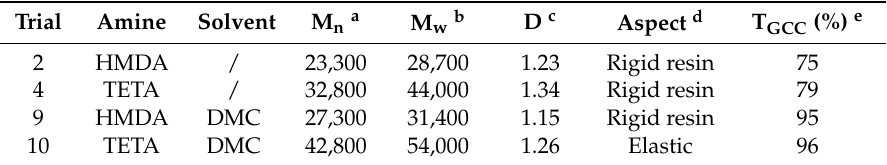
Table 3. One-pot strategy; influence of DMC solvent on the synthesis of amino ethylene ester PHUs. T = 90 °C, duration = 2 h.